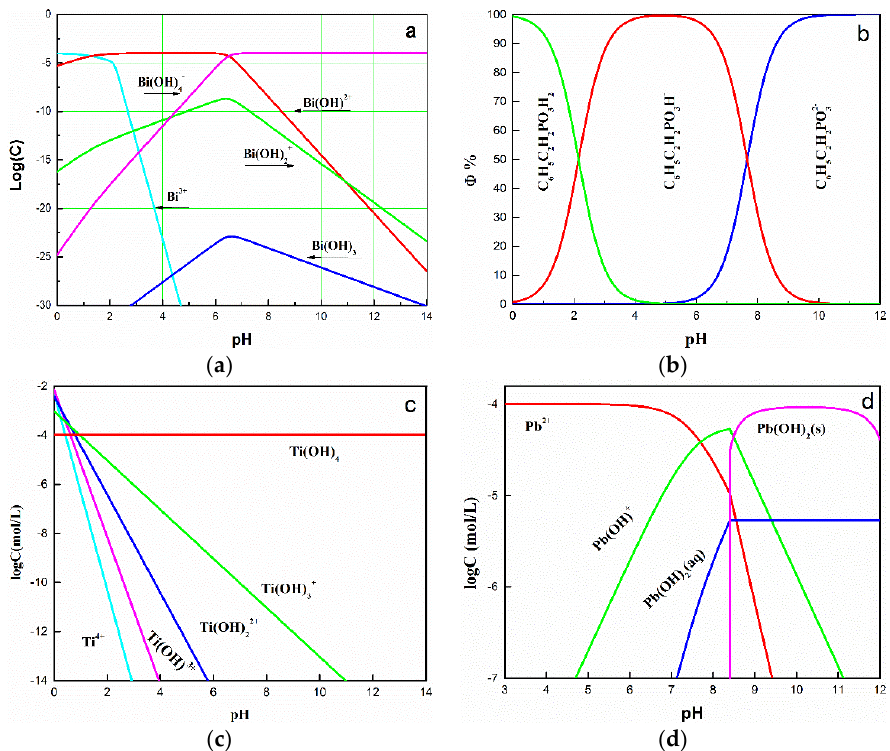
Figure 8. ΔZeta potential of rutile surface with a function of pH: Δ1 is the difference before and after SPA addition without activation ions; Δ2 is the difference before and after SPA addition with Pb 2+ ions; Δ3 is the difference before and after SPA addition with Bi 3+ ions.